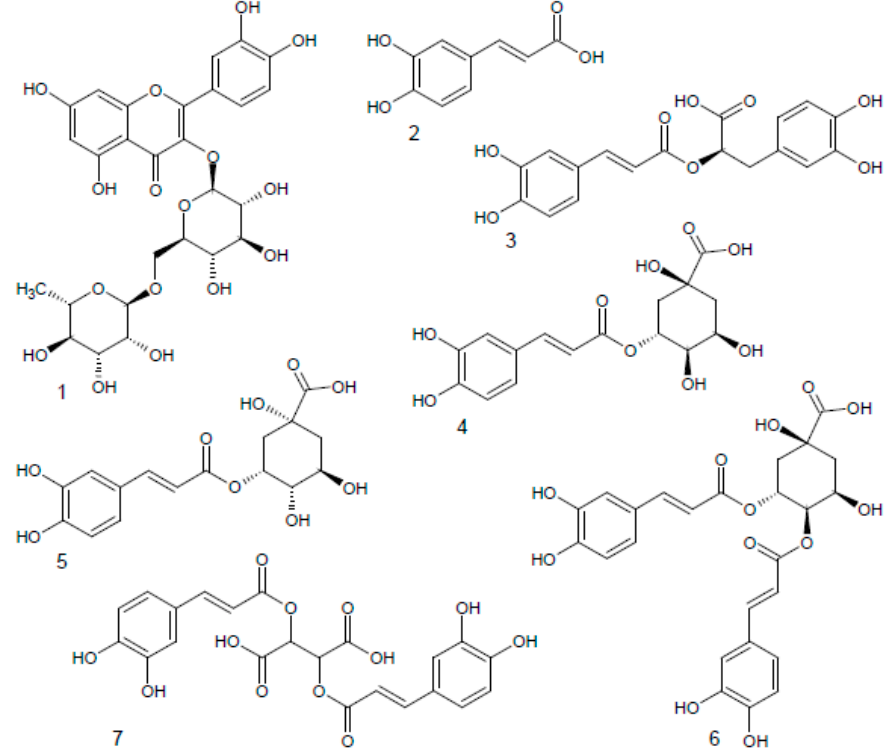
Figure 2. Chemical structures of identified phenolic compounds: (1) rutoside; (2) caffeic acid; (3) rosmarinic acid; (4) chlorogenic acid; (5) neochlorogenic acid; (6) isochlorogenic acid b; (7) cichoric acid. als, cichoric acid was a clear dominant (2647.90 mg × 100 g − 1 , 1381.06 mg × 100 g − 1 , respec- fied represent cinnamic acid derivatives. Caffeic acid is a free compound, while others are depsides representing its esters. Here, rosmarinic acid is an ester of caffeic and 3,4-dihy- droxyphenyllactic acid, while chlorogenic, neochlorogenic, isochlorogenic b and cichoric acids are esters of caffeic and quinic acid, thus belong to caffeoylquinic acid isomers, as following: